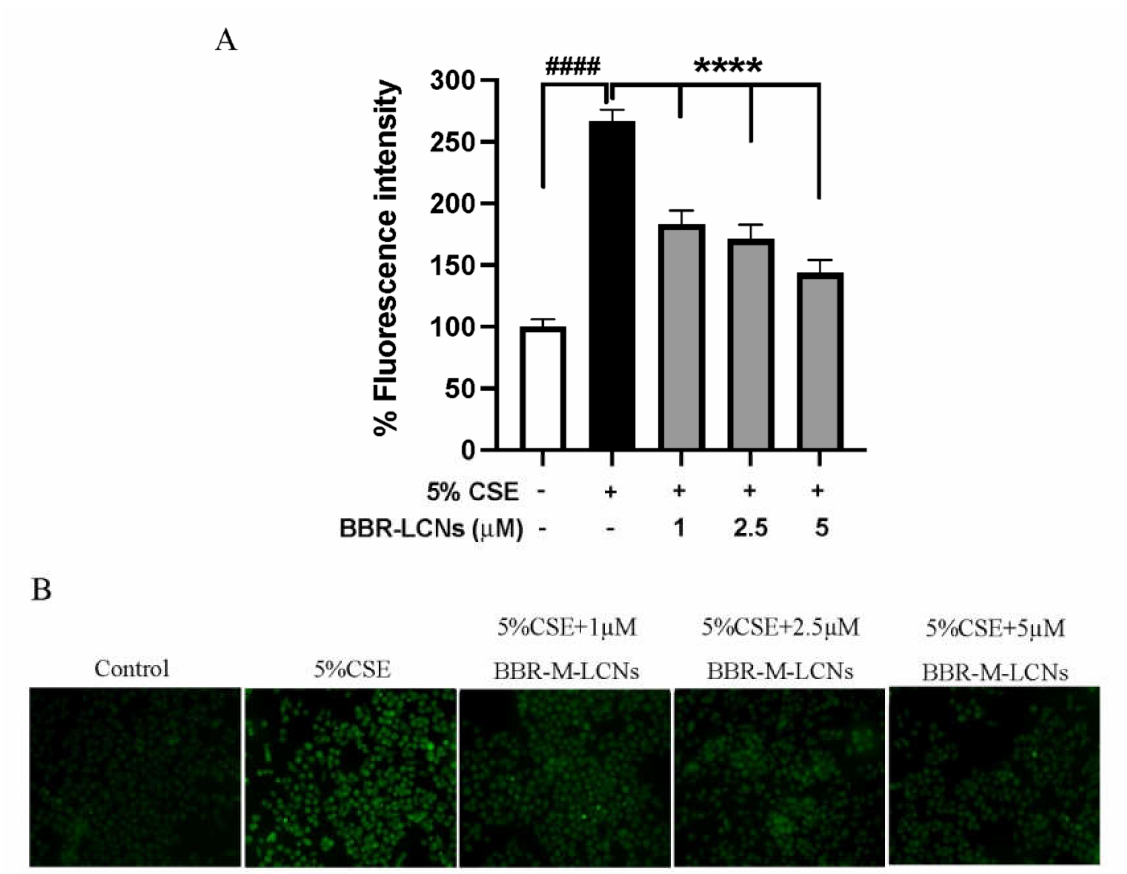
Figure 7. Effect of BBR-LCNs on ROS production in RAW264.7 cells. ( A ) Measurement of fluores- cence intensity. The fluorescence intensity was measured at an excitation 485 nm and an emission 535 nm; n = 3 independent experiments and each independent experiment contained 6 replicates. Values are expressed as mean ± SEM. Analysis was carried out using one-way ANOVA followed by Dunnett’s multiple comparison test. ( B ) Fluorescence imaging. The DCF-DA fluorescence stain- ing images of RAW264.7 cells treated with 5% CSE and with/without different concentrations of BBR-LCNs were captured with Zeiss Axio Imager Z2 microscope at 40 × magnification. 3.9. Inhibition of Oxidative Stress and Inflammation-Related Gene Expression in RAW264.7